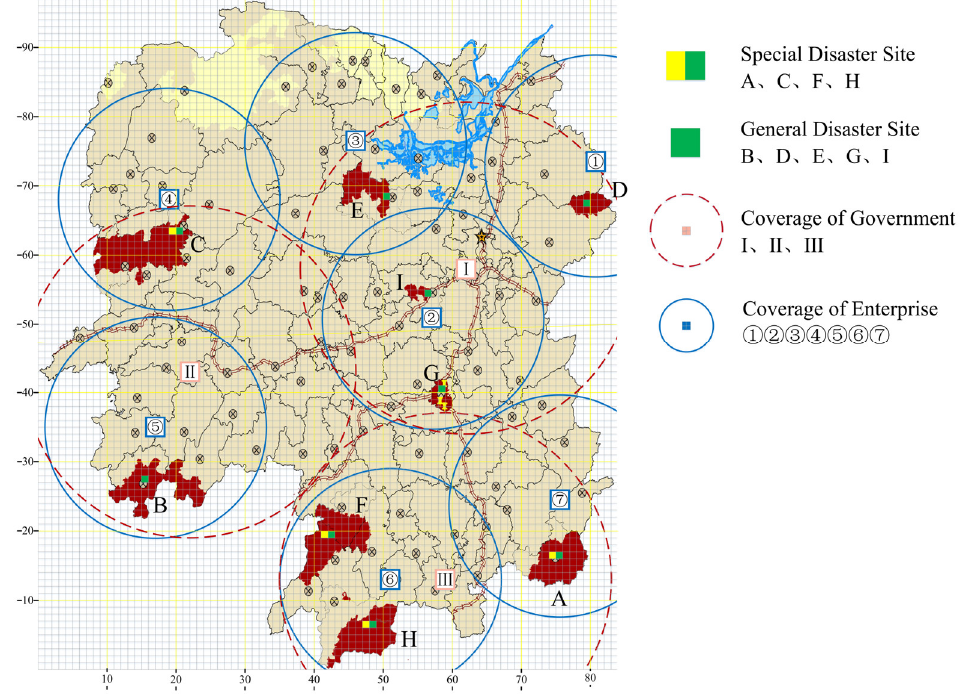
Figure 11. Emergency network design and facility layout. Table 3. The demand of emergency resources in phases.